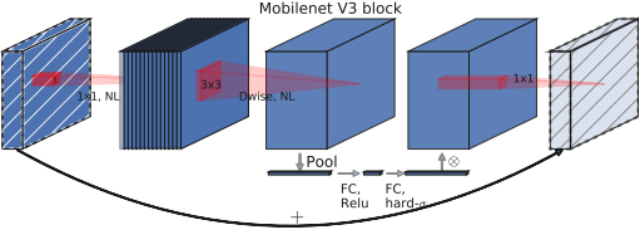
Figure 6. Detailed architecture of MobileNetV3 neural network architecture